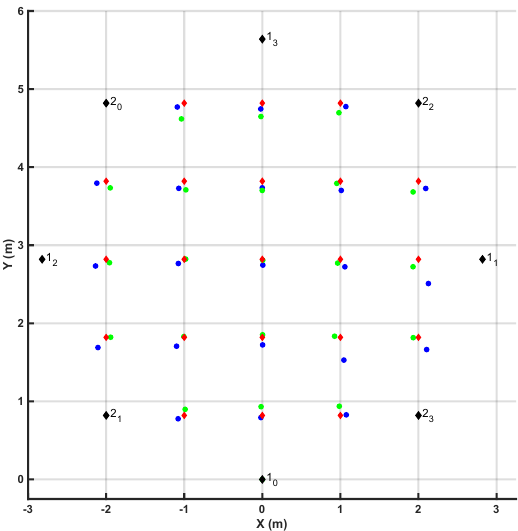
Figure 10. Comparison of the results obtained with vs. without correction algorithm when eight anchor units were used to derive the position of the radio tag. The black markers represent the coordinates of the anchors. The red markers represent the actual position of the radio tag for all tested positions, the blue markers represent the estimated positions before the correction algorithm was applied, and and the green markers represent the coordinates after the correction algorithm was applied.